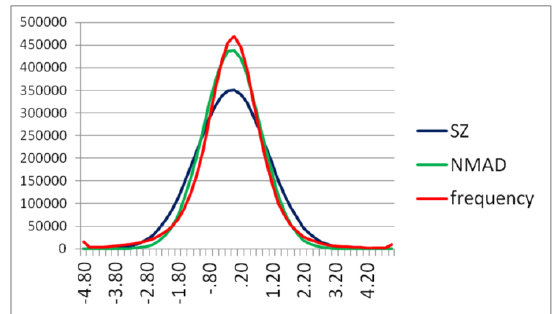
Figure 15. Frequency distribution of the difference height model 283-284 against